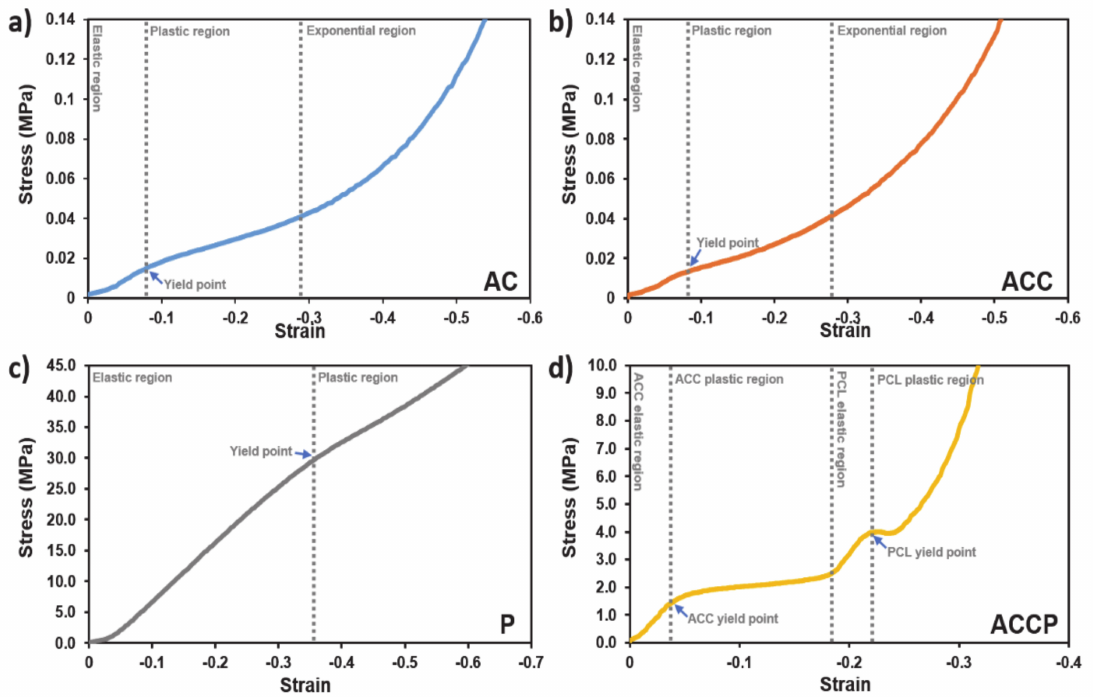
Figure 5. Compressive behavior of the ( a ) AC, ( b ) ACC, ( c ) P, and ( d ) ACCP 3D printed scaffolds. Distinct transition regions of the stress-strain curve are clearly marked for each specimen. The blue arrows indicate the yield points for individual